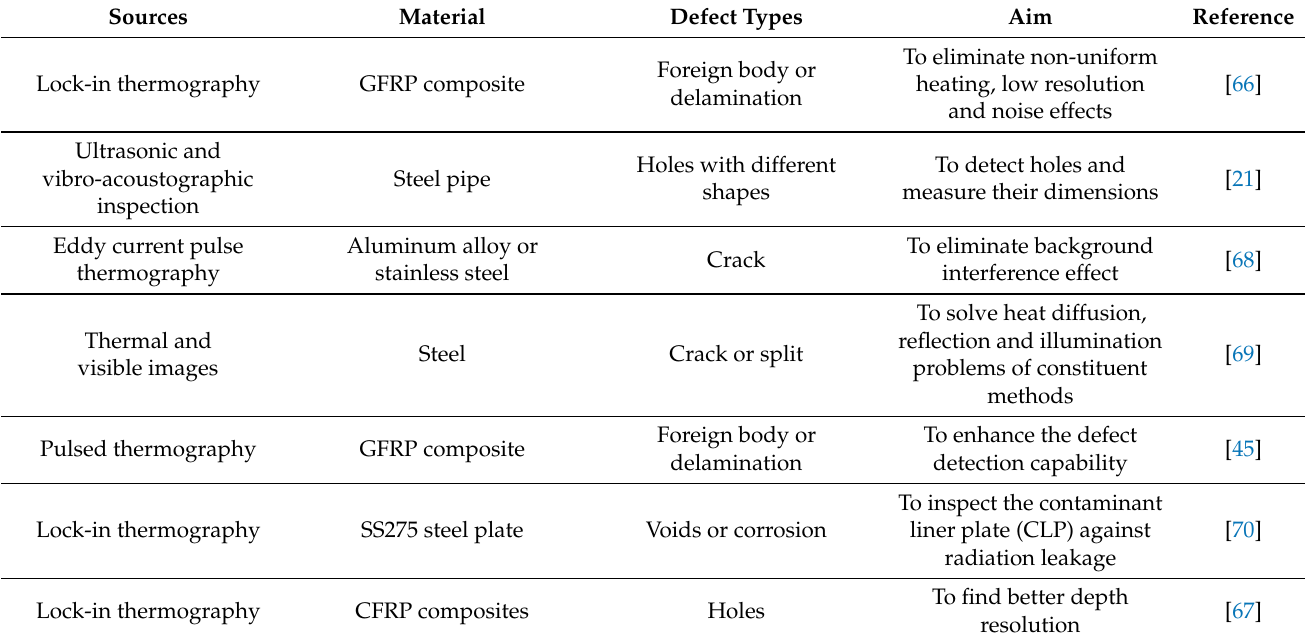
Table 4. A list of PCA-based studies for NDT image